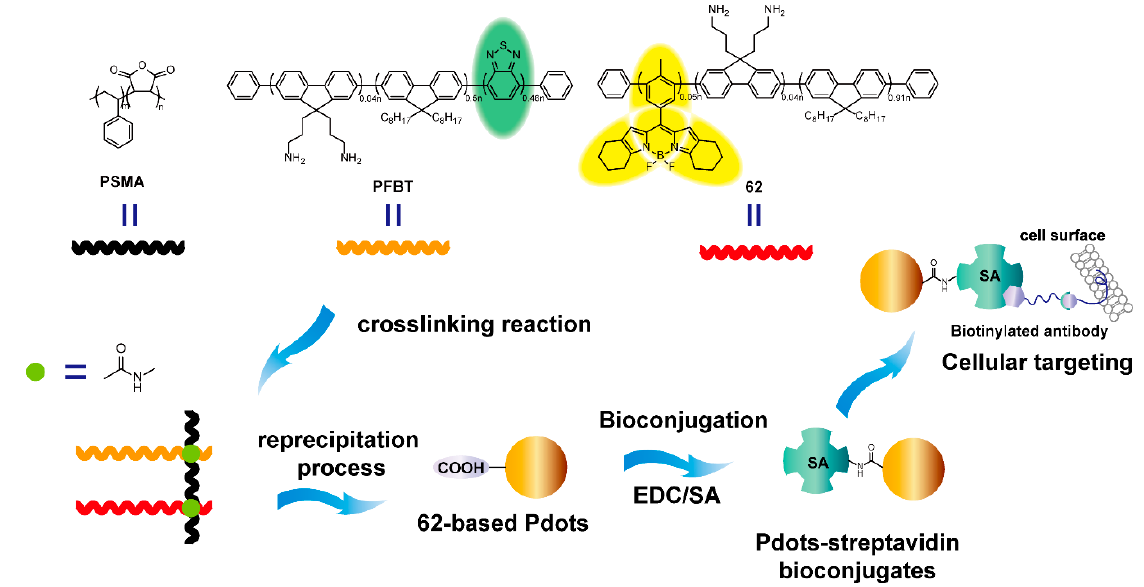
Figure 20. Schematic illustration of the preparation of crosslinked semiconducting polymers with poly(styrene-co-maleic anhydride) (PSMA), poly[9,9-dioctylfluorenyl-2,7-diyl-co-1,4-benzo-(2,1 ′ -3)-thiadiazole] (PFBT), and 62 , and 62 -based pol- ymer dots (Pdot) bioconjugates for specific cellular targeting (Reproduced with permission from Reference [91]. Copyright @ 2014 ACS publication).